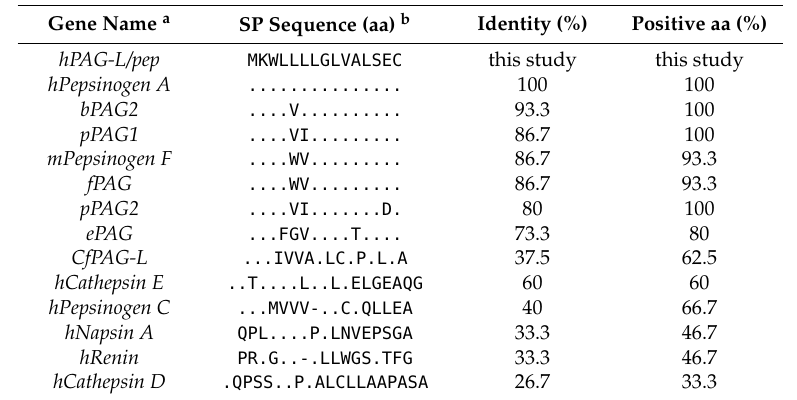
Table 1. Signal peptide (SP) sequence homology of the hPAG-L/pep polypeptide precursor to various aspartic